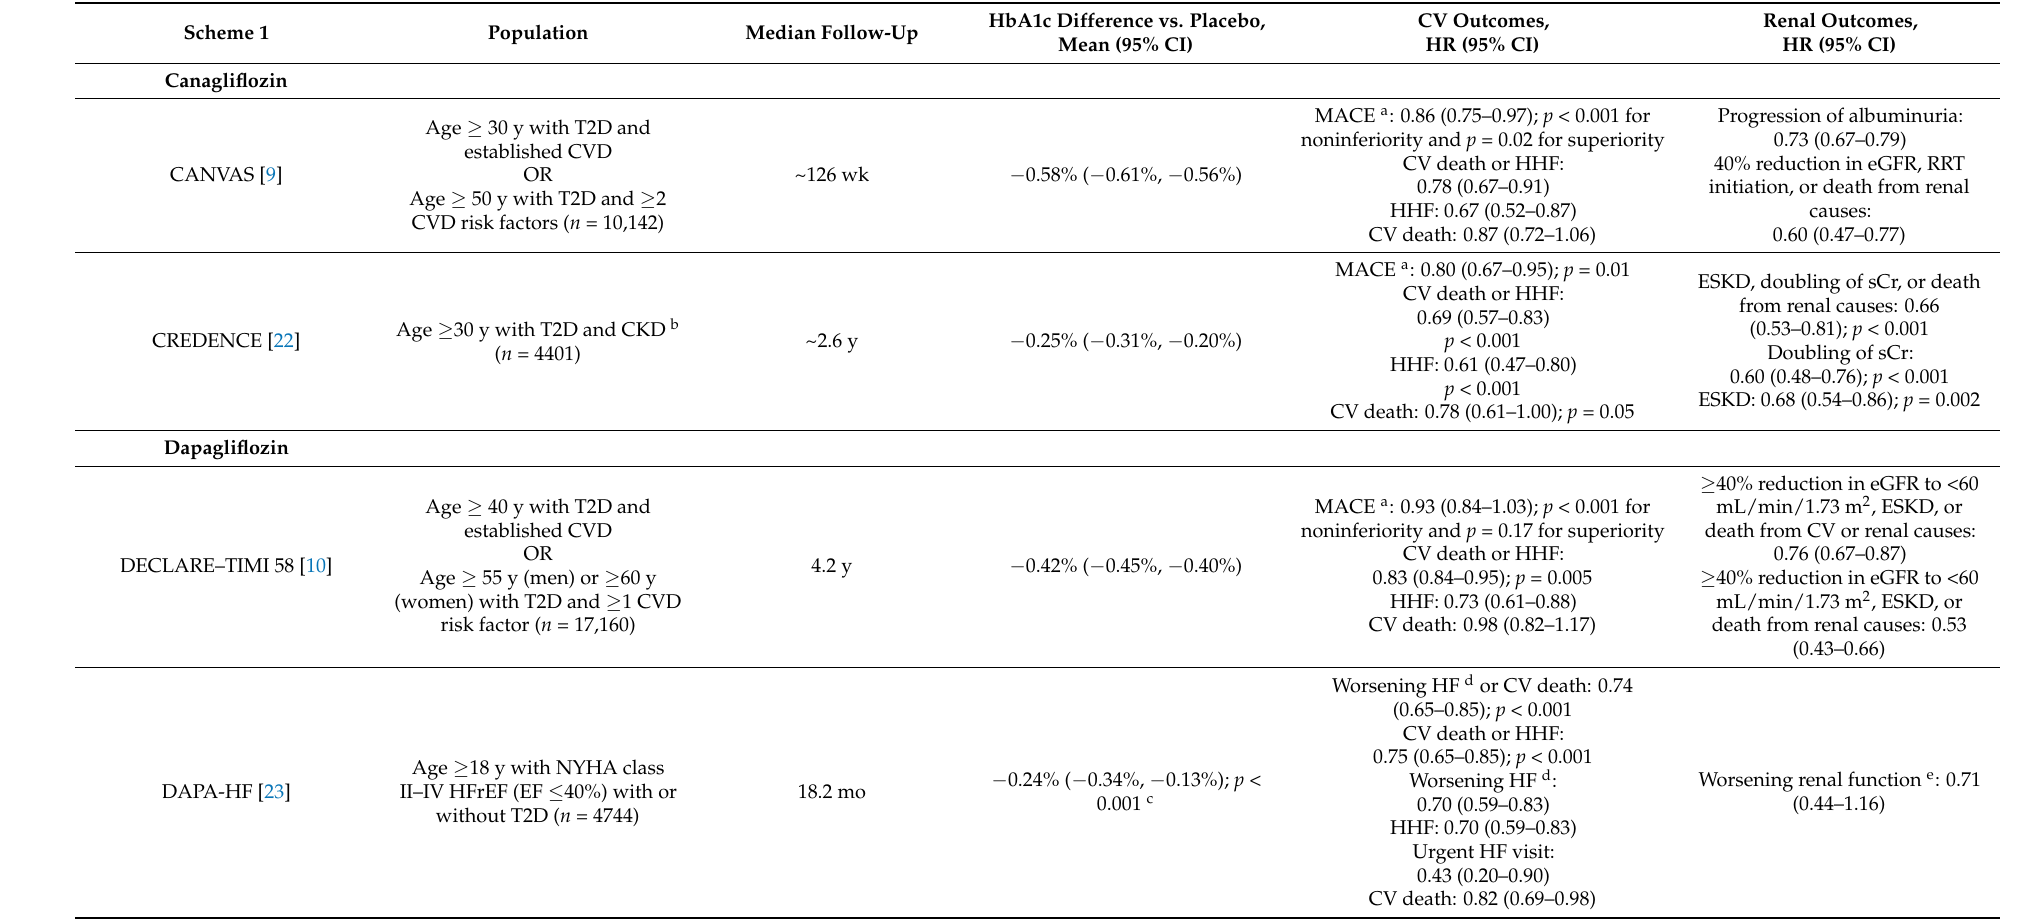
Table 1. Summary of glycemic, cardiovascular, and renal end points in the SGLT-2i outcome